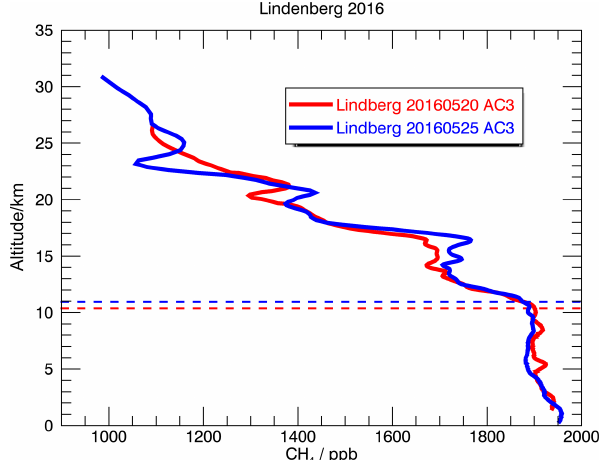
Figure 10. Vertical profiles of CO 2 derived for the flights on 20 and 25 May 2016 from Lindenberg in Germany. The flight on 25 May reached higher altitudes due to a larger balloon. The dashed lines represents the thermal tropopause according to the WMO